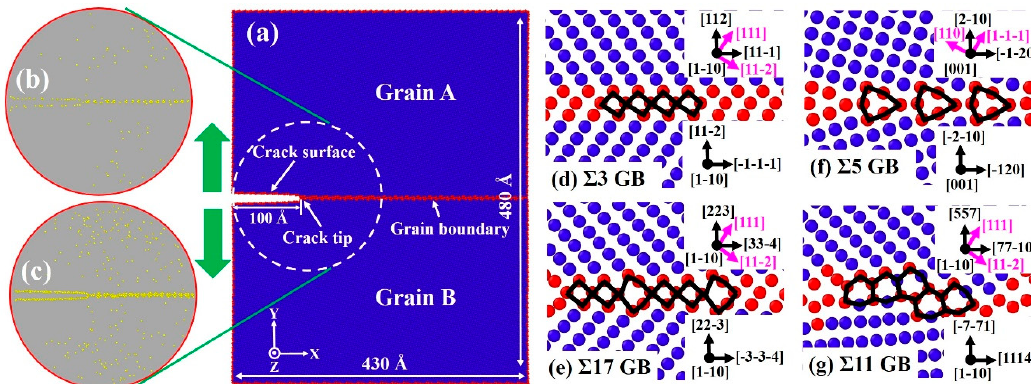
Figure 1. Molecular dynamics (MD) simulation setup for the mode-I fracture along the tilt boundary. ( a ) Geometry and crystallographic orientations of bicrystalline nanowire. ( b , c ) H distribution around the crack tip with 45 and 135 mppm H atoms. ( d – g ) Atomic configurations of the equilibrium structure of various grain boundary (GB) types. Images are colored by common neighbor analysis (CNA), where atoms with a body-centered cubic (bcc) structure are colored in blue, atoms at the GB and free surface are colored in red, and H atoms are assigned in yellow. The structural units of each GB are outlined by the black line. Possible dislocation slip systems are indicated with pink arrows.